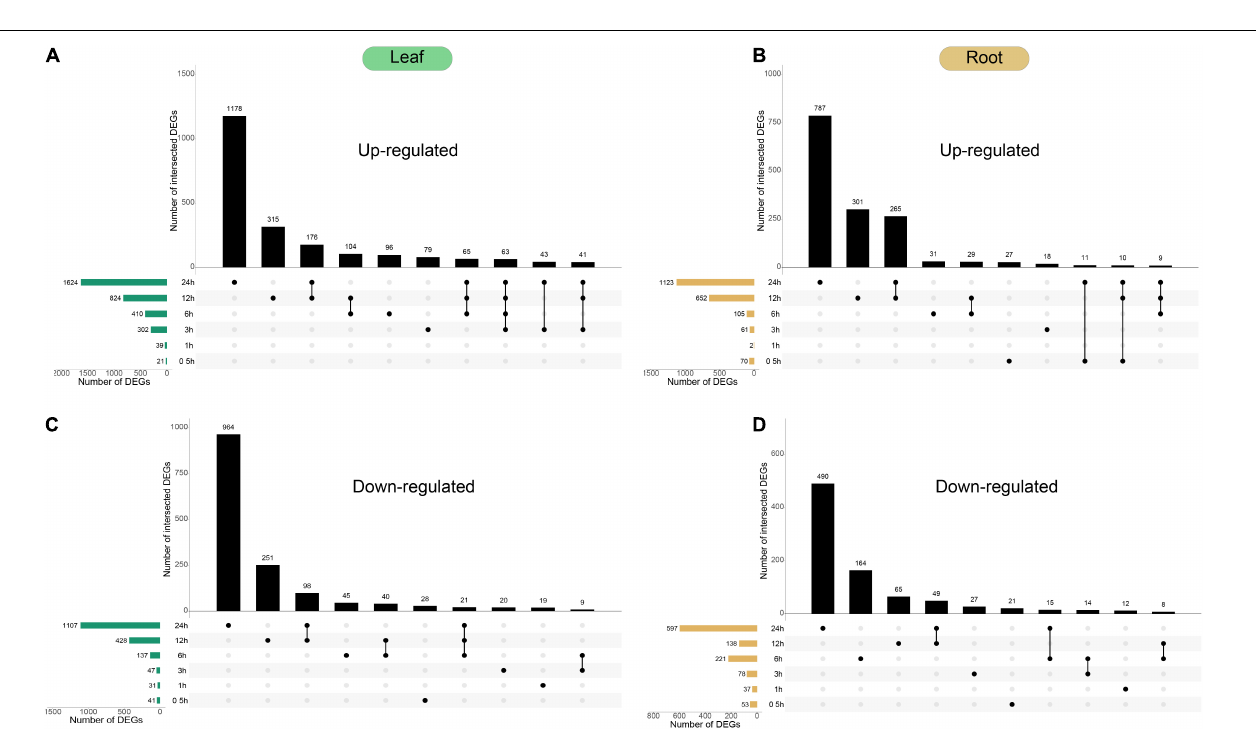
FIGURE 3 | Gene ontology (GO) terms for three clusters under cold stress conditions. (A–C) GO terms of cluster 3 (1,256 genes) (A) , cluster 9 (941 genes) (B) and cluster 15 (1,804 genes) (C) all genes at the cellular component (CC), molecular function (MF), and biological process (BP). The complete list of cluster genes and GO terms for enrichment analysis is shown in Supplementary Tables 5–7 .